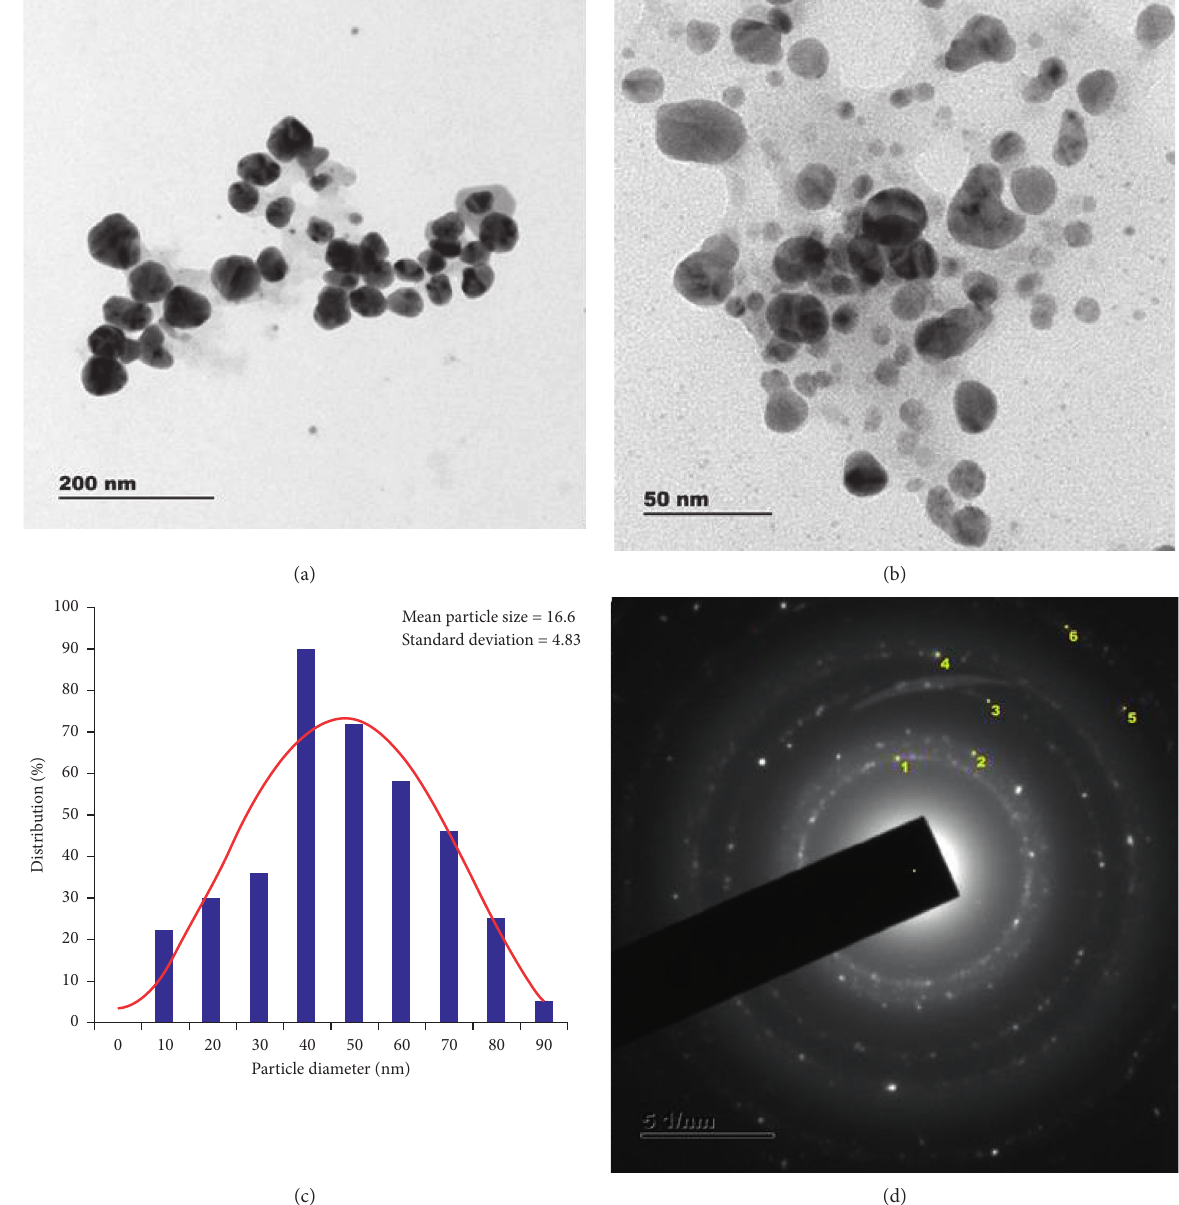
Figure 7: TEM images (a and b), particle size histogram (c), and corresponding SAED pattern (d) of Ag